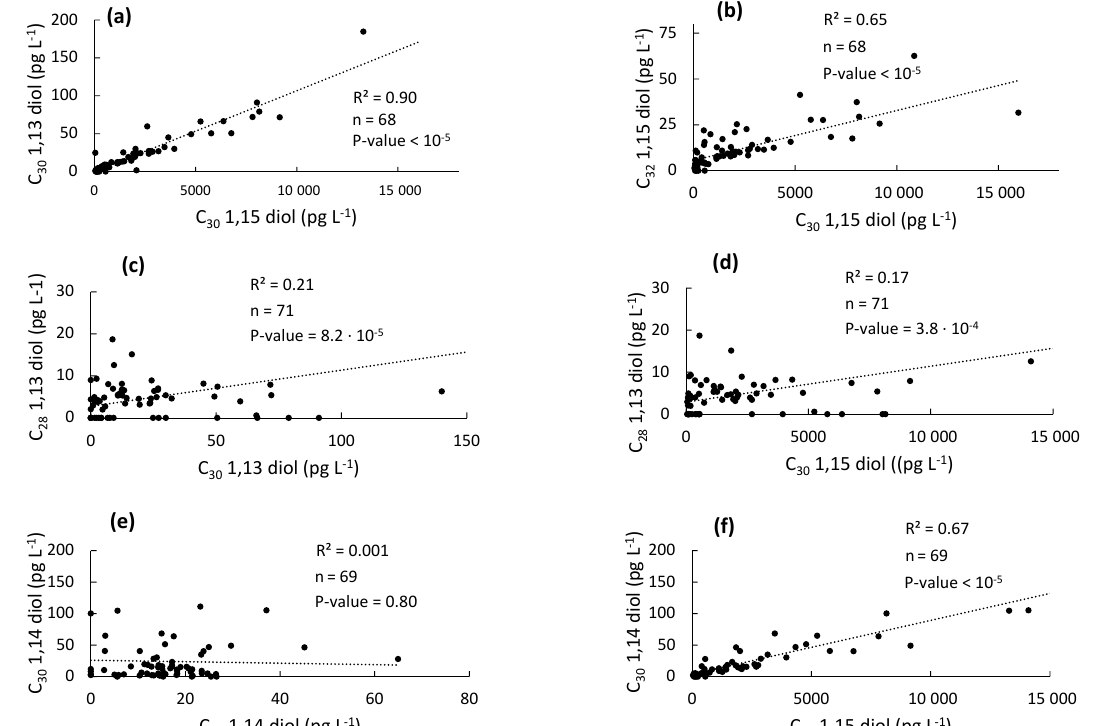
Figure 5. Scatter plots of the concentrations of the different LCDs in the western tropical Atlantic Ocean. (a) C 30 1,13-diol vs. C 30 1,15-diol, (b) C 32 1,15-diol vs. C 30 1,15-diol, (c) C 28 1,13-diol vs. C 30 1,13-diol, (d) C 28 1,13-diol vs. C 30 1,15-diol, (e) C 30 1,14-diol vs. C 28 1,14- diol, and (f) C 30 1,14-diol vs. C 30